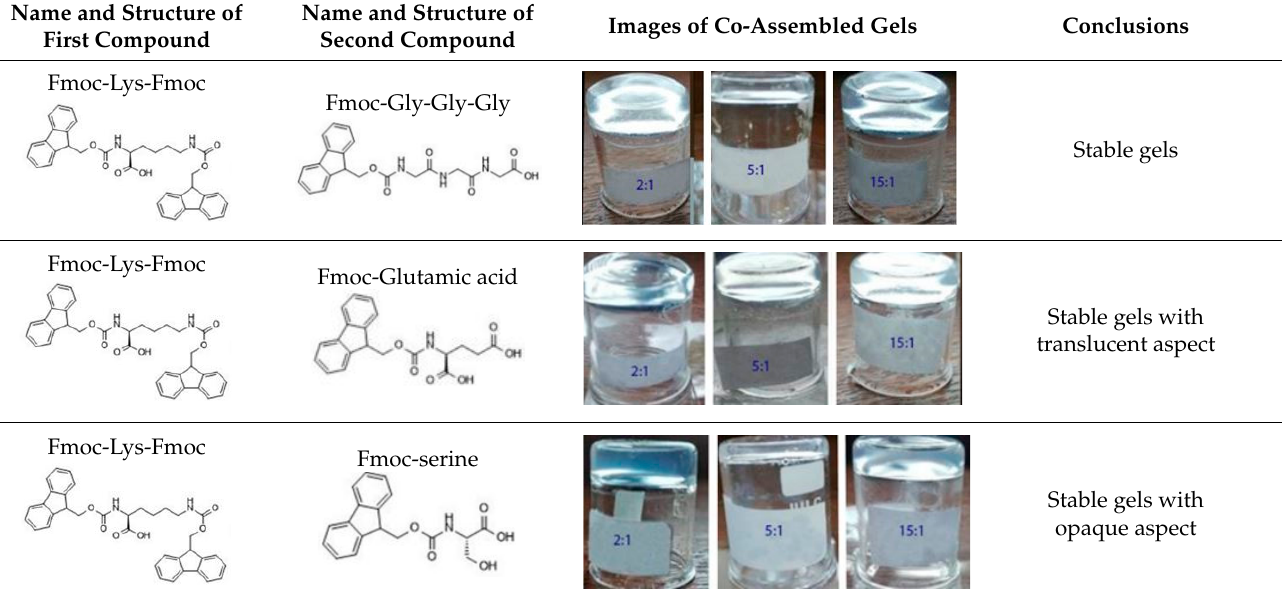
Table 2. Name and structure of compounds used in the co-assembled